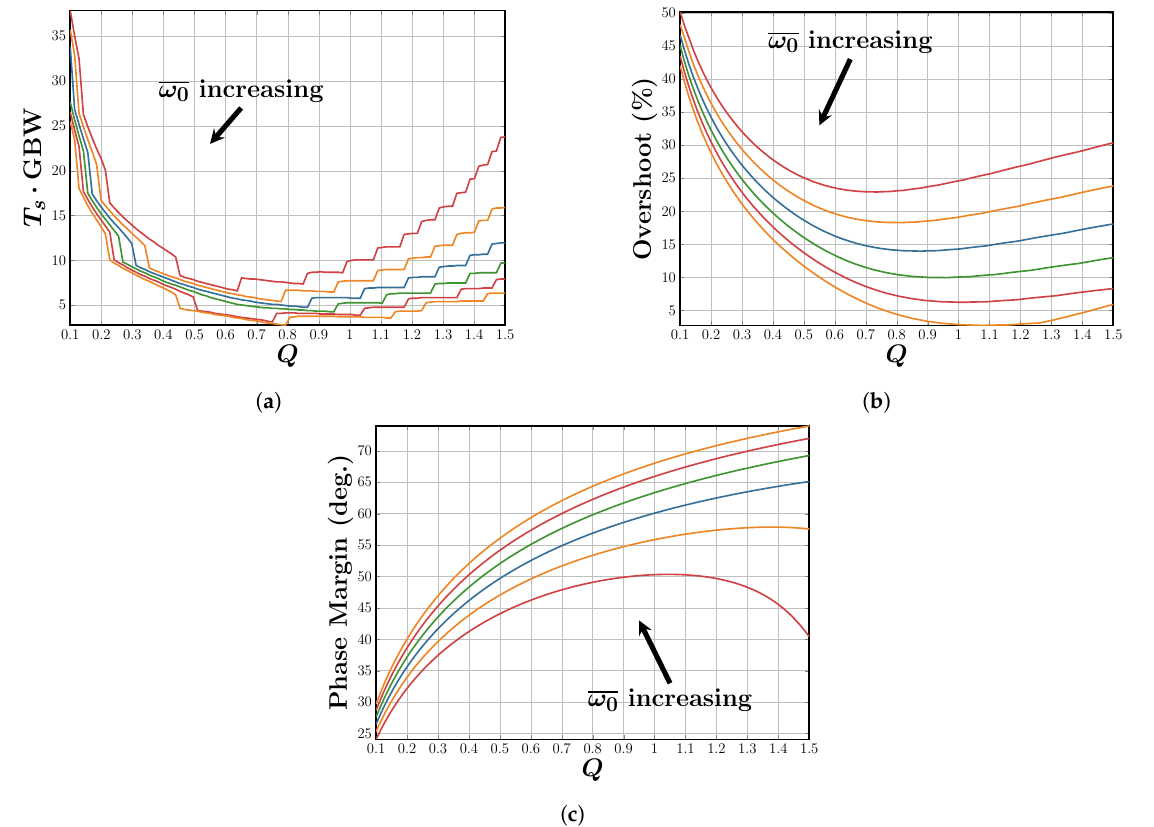
Figure 4. Response of the OTA given by Equation (1) as a function of Q for values of ω 0 increasing from 2 to 3 with steps of 0.2: ( a ) normalized settling time of the unity-gain feedback step response; ( b ) overshoot percentage of the unity-gain feedback step response; and ( c ) phase